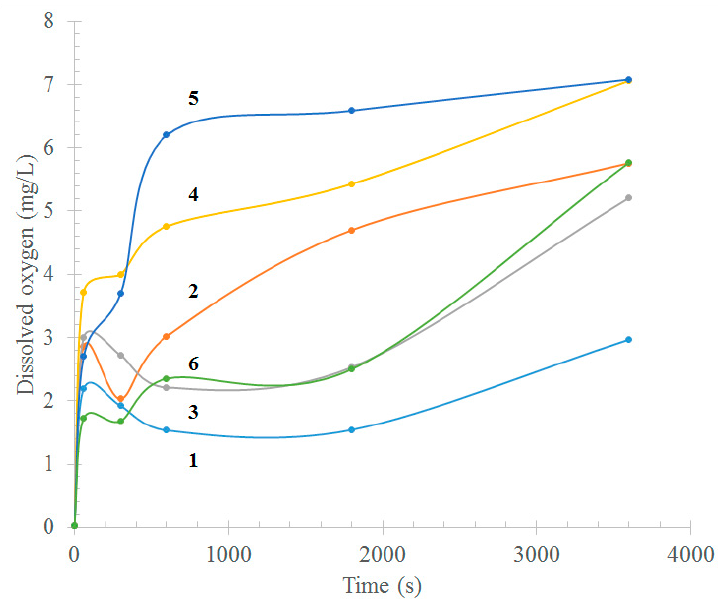
Figure 3. Time course of oxygen dissolution in wine glass under firm conditions. Legend: lines 1–6 refer to different glass shapes (see Table 1 for details).